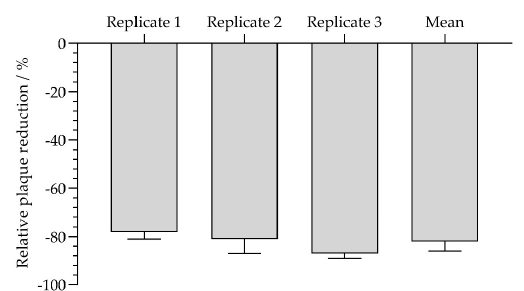
Figure 10. Result of the curative plaque assay. Plaque reduction of 40% isla ® medic Conc. 3 (0.077 g lozenge/mL) in the overlay medium on infected H1-HeLa cells and mean ± standard deviation of the independent test runs with three repetitions. Plaque reduction is shown in relation to the untreated control (overlay medium with 40% 2× Conc. EMEM).